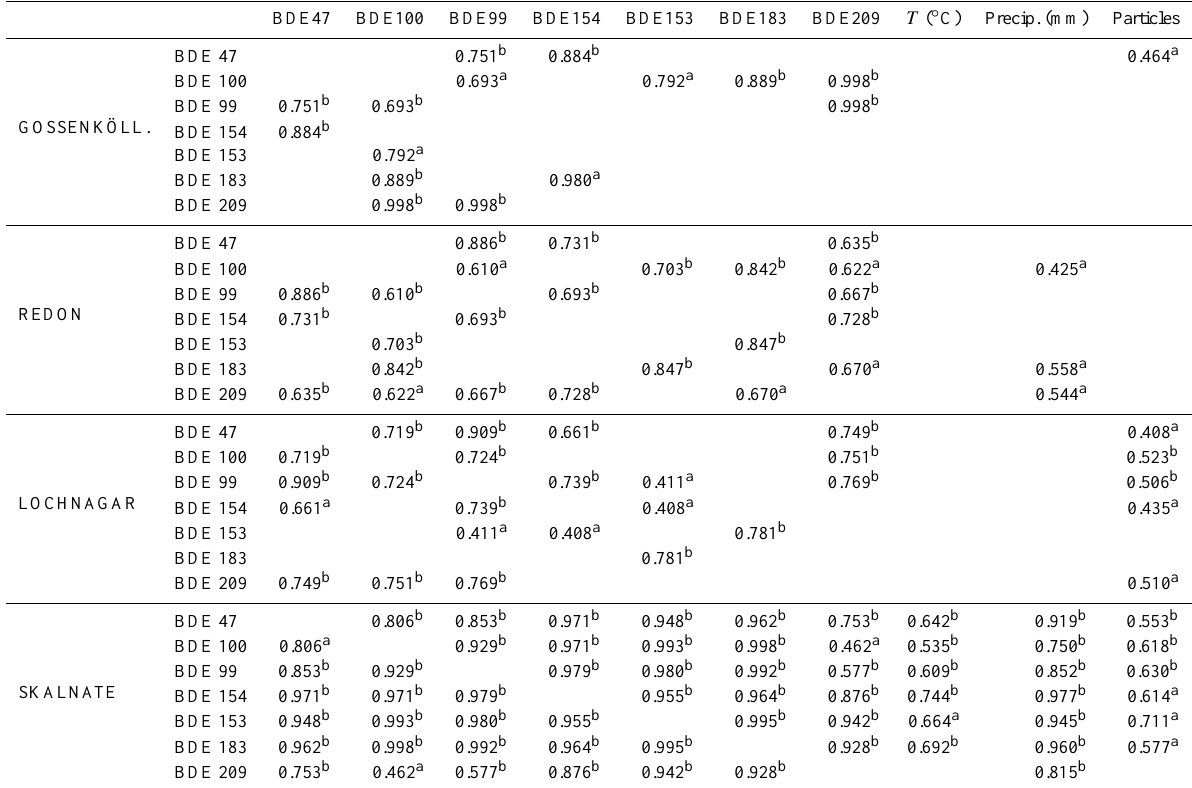
Table 7. Pearson correlation coefficients between individual BDE congeners (ngm − 2 mo − 1 ) , particle fluxes (mgm − 2 mo − 1 ) and meteoro- logical variables. Correlations calculated from log-transformed values, excepting for temperature and precipitation. Only statistical significant correlations are indicated.